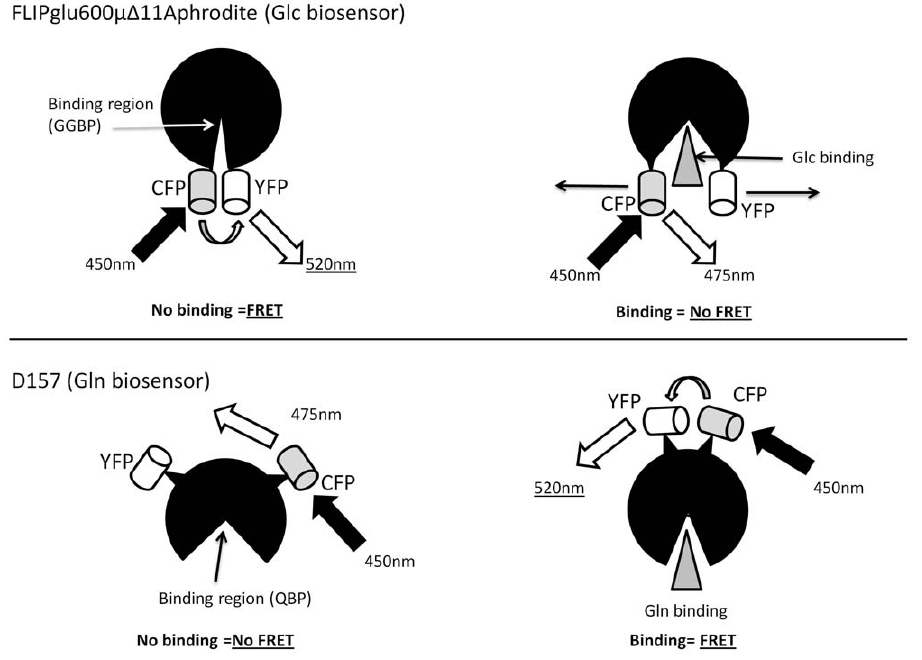
Figure 2. Diagrammatic representation of FRET sensor function. a) The glucose biosensor has maximum FRET efficiency in the absence of ligand. The binding of glucose causes a twist in the alignment of the fluorophores which causes the FRET ratio to decrease. b) The glutamine biosensor has maximum FRET efficiency in the presence of ligand which causes the binding domain to hinge closed, bringing the fluorophores into closer contact.